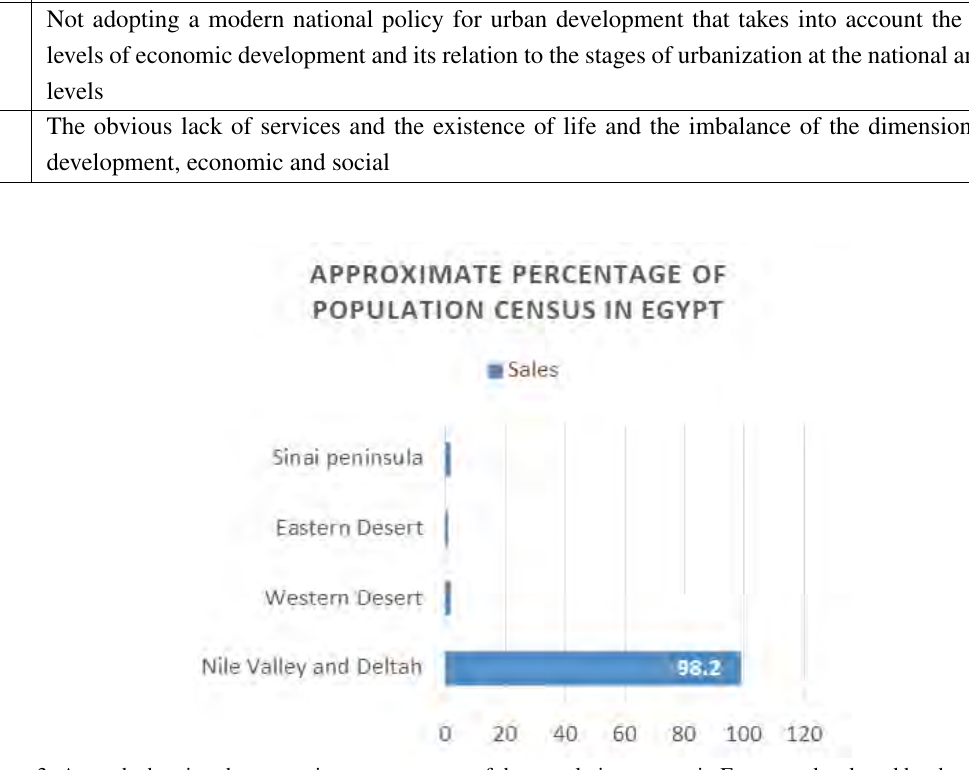
Figure 3. A graph showing the approximate percentage of the population census in Egypt — developed by the researchers. Source: Central Agency for public Mobilization and statistics in Egypt — www.capmas.gov.eg